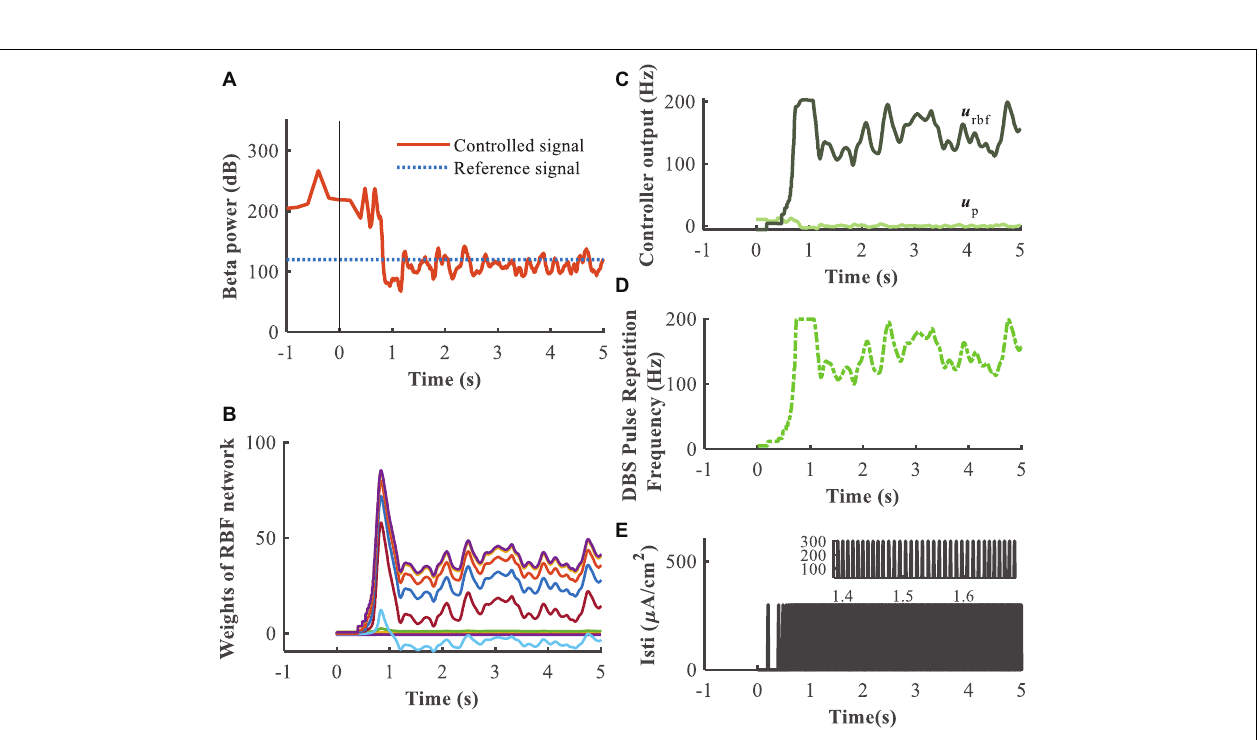
FIGURE 9 | Feedback control using the RBF controller with beta power as the control signal ( k p = 0 . 1 ) . Panel (A) depicts the dynamic process of the controller reducing beta power in the GPi, panel (B) shows the evolution of real-time updated weights of the RBF network, (C) plots the trend of P controller and RBF controller, respectively, (D) generates the DBS pulse repetition frequency. Panel (E) is the stimulation signal, a series of 0.3 ms duration 300 µ A / cm 2 amplitude pulses with the instantaneous frequency determined by the controller.